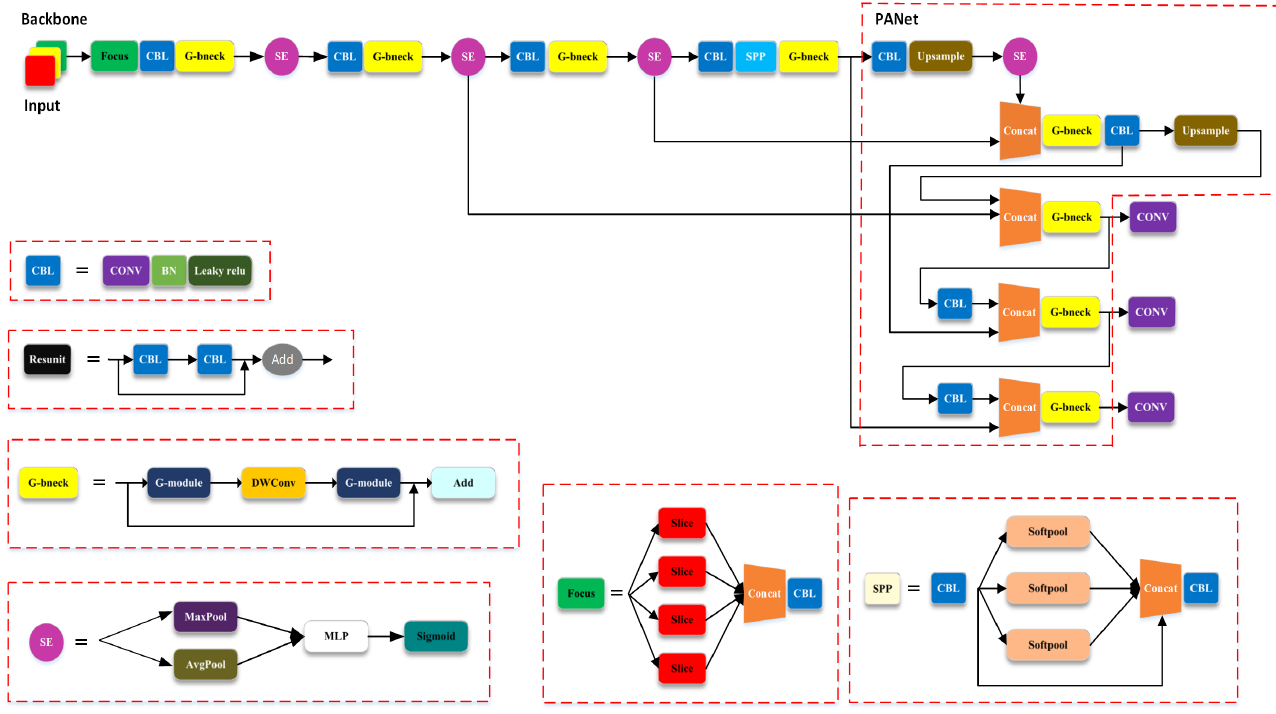
Figure 8. The network structure of improved